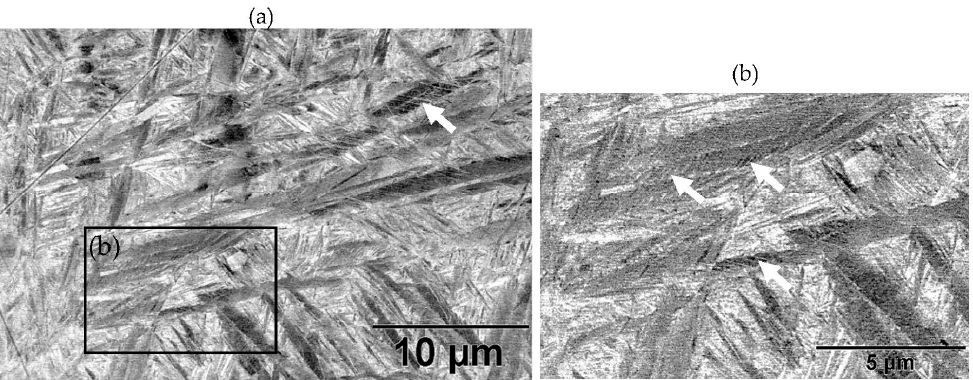
Table 4. Hierarchical structure of α ’.